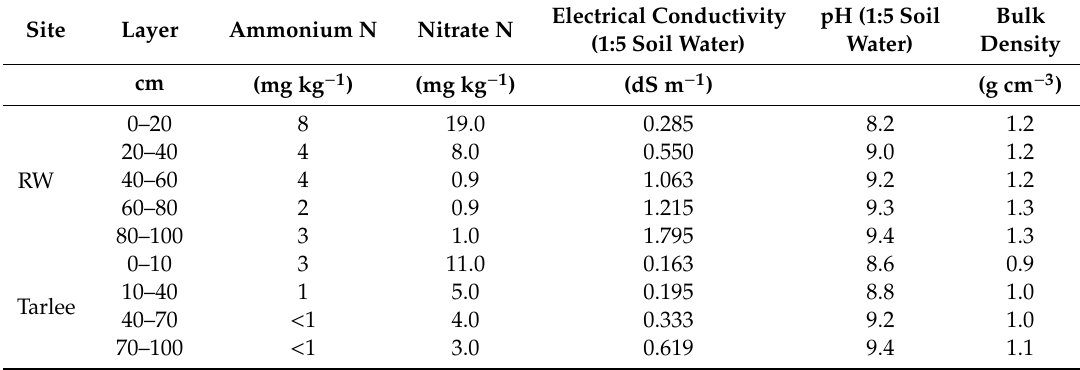
Table 1. Soil characteristics of Roseworthy (RW) and Tarlee sites used in 2013. Analyzed by CSBP Soil and Plant Analysis Laboratories, Perth WA, as explained by Rayment and Lyons